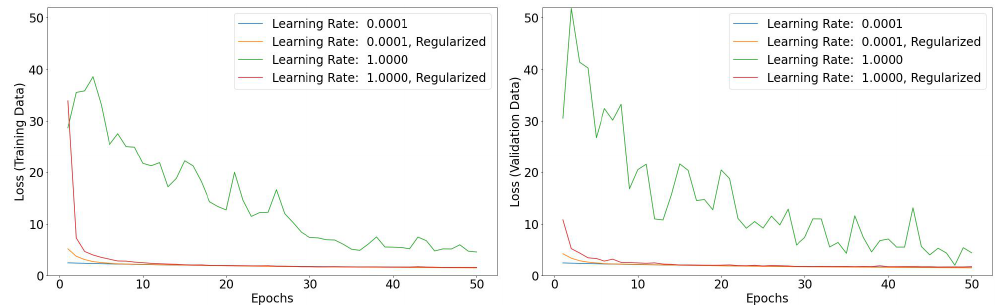
Figure 3. Comparison of cross-entropy loss for different learning rates with and without regulariza- tion ( left panel shows results for training data, right panel for validation data).